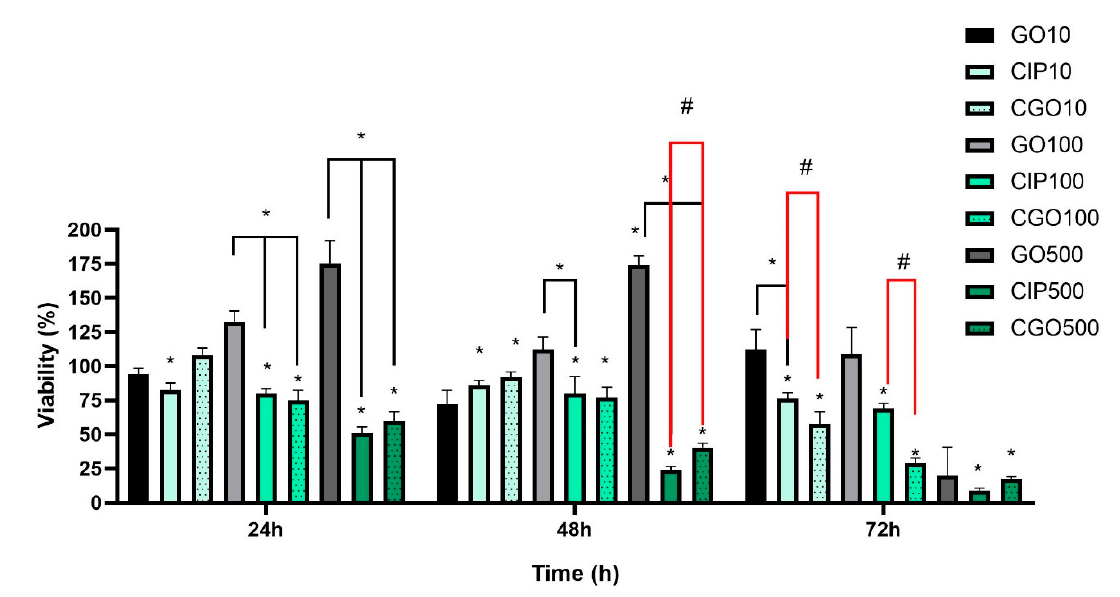
Figure 5. The results of the MTT test for the 786-0 line in the following days from the start of incubation with the addition of ciprofloxacin and ciprofloxacin modified from the 10–500 µ M concentration range and graphene oxide in the concentration range of 10–500 µ g / mL. Statistically significant di ff erences compared to the control marked as “*” above the averages on the graph. Statistically significant di ff erences between variants marked as “*” above a clamp ( p < 0.05); “#”—statistically significant di ff erence between the corresponding concentrations of ciprofloxacin and modified ciprofloxacin ( p <